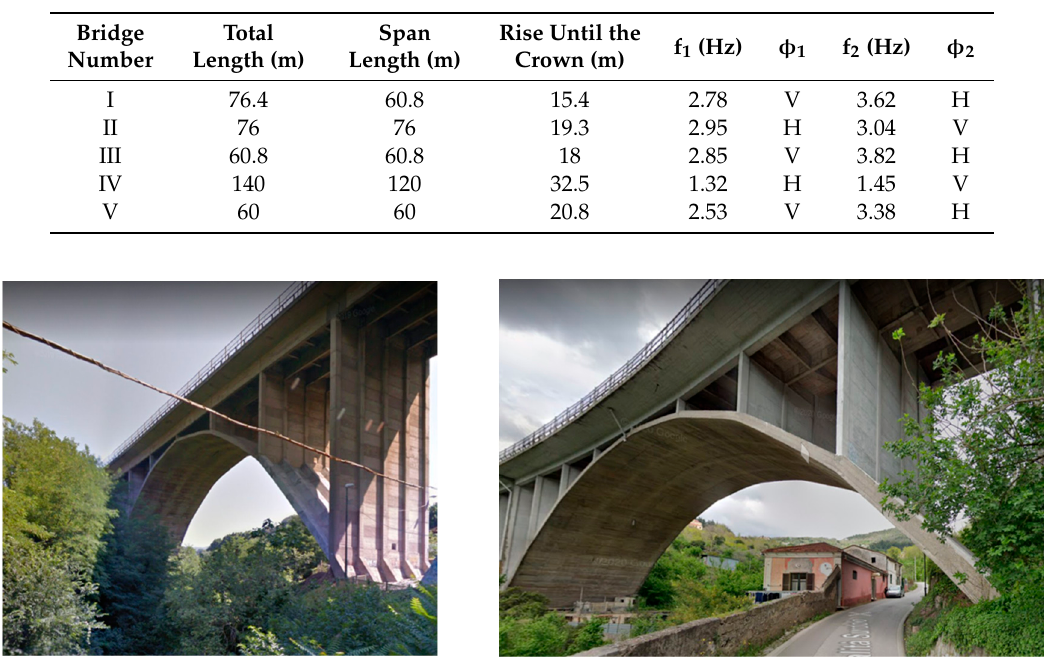
Figure 1. Sample images representative of the tested RC arch bridges (source: maps.google.it). Table 1. Fundamental modal properties of a set of highway RC bridges in Southern Italy ( ϕ i means the i-th mode shape, V is for vertical bending, H is for horizontal bending).